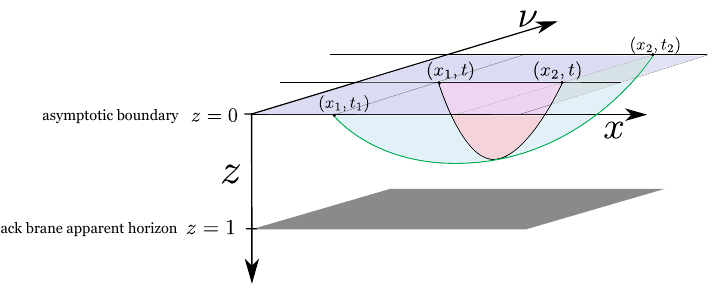
Figure 7 . A schematic representation of the boundary conditions used in this